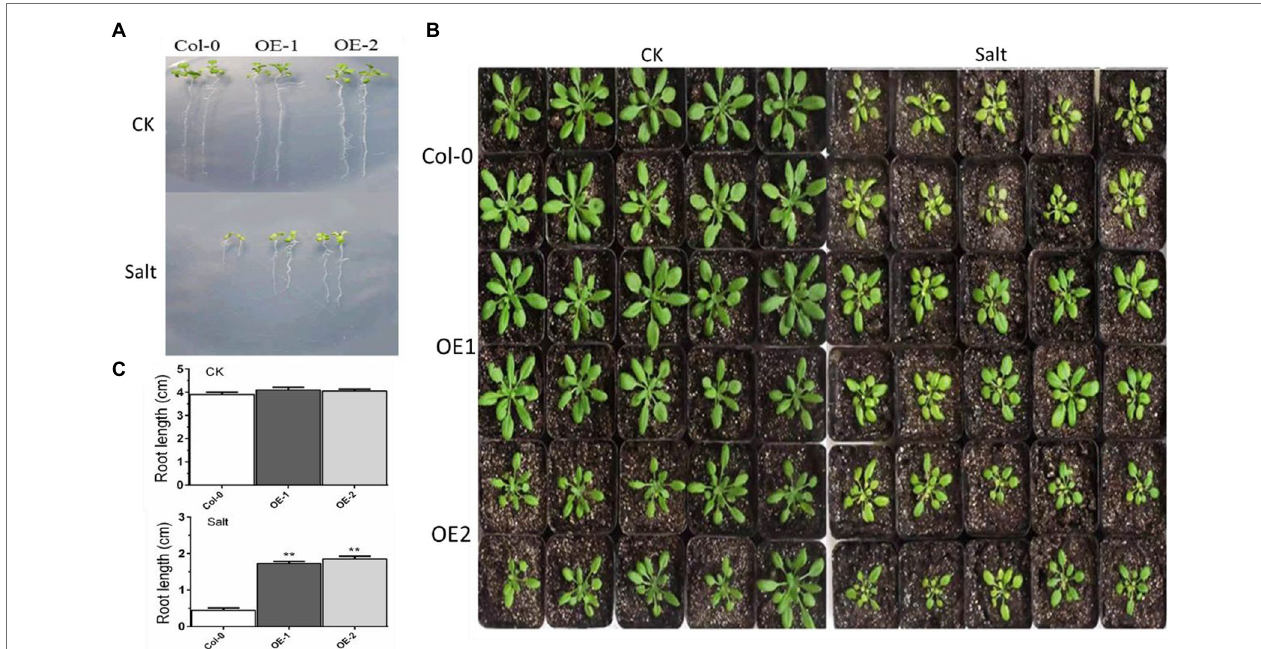
FIGURE 2 | Effects of MYB37 overexpression on phenotypes of Arabidopsis seedlings (A) and 4-week-old adult (B) under NaCl stress. Figure 2A shows the phenotype of Arabidopsis seedlings grown on MS medium for 3 days, then transferred to 1/2MS medium with 0 mm or 100 mM NaCl for 7 days. Figure 2B shows the phenotype of Arabidopsis seedlings cultured in the soil after watering with an equal volume of distilled water and 100 mM NaCl solution for 2 weeks. Figure 2C shows statistics of the primary root lengths of the plants as described in (A) . Student’s t -test was used to compare the primary root lengths of transgenic line with WT plants (with significant differences at ** p <